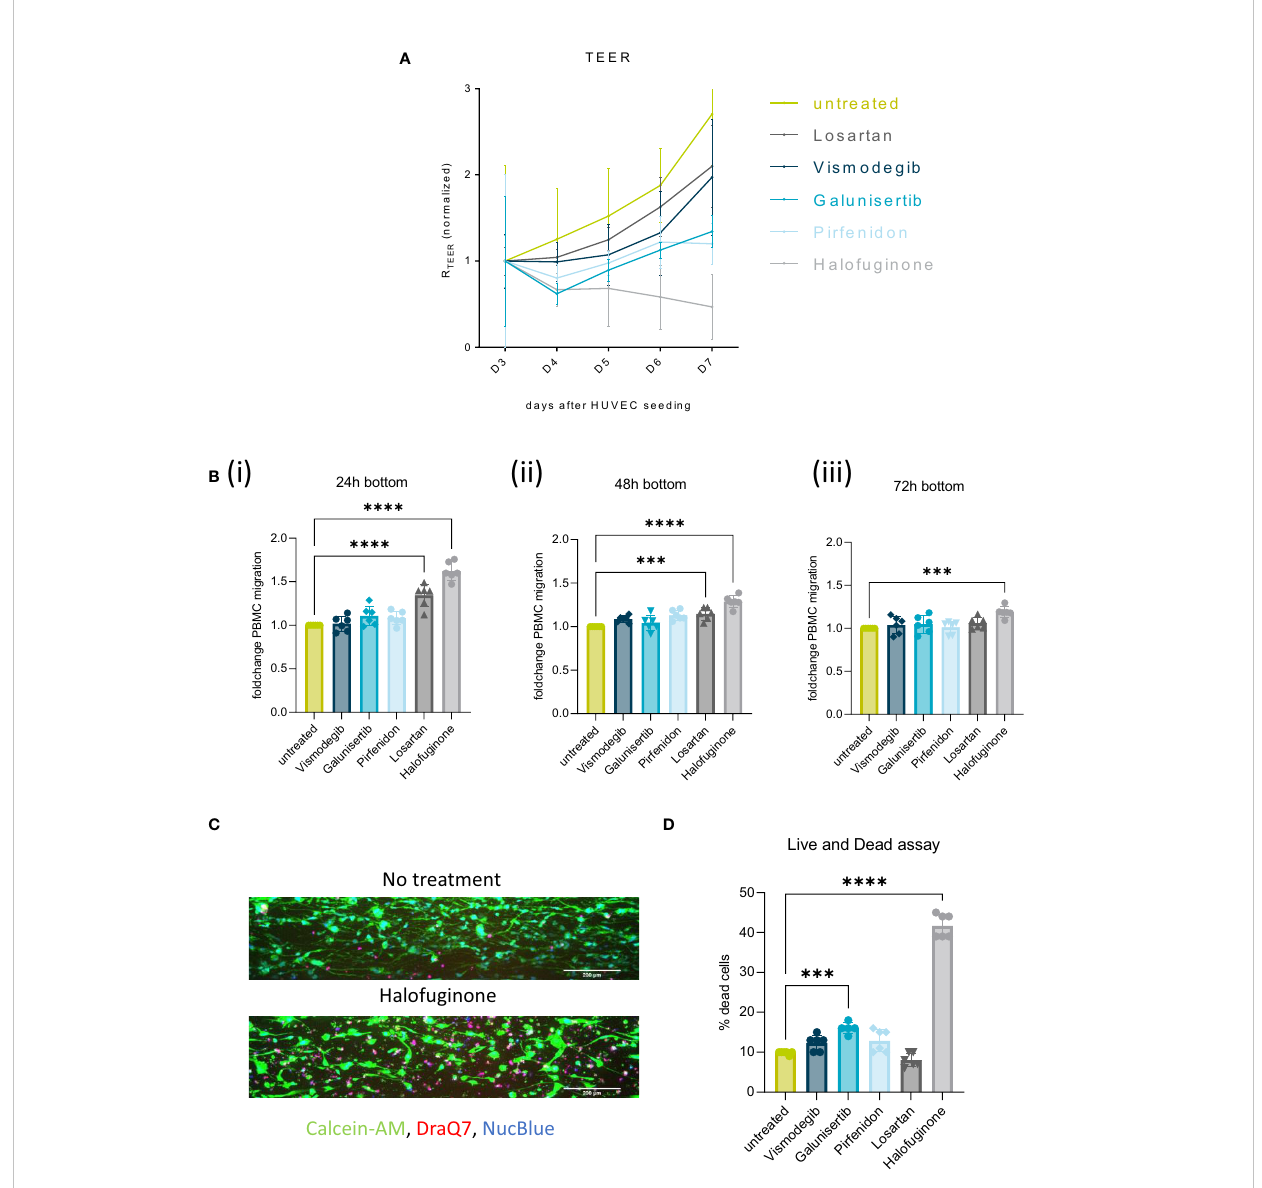
FIGURE 6 Stromal targeting in PDAC: (A) Barrier assessment of the culture setups when treated with 2 µM of either Vismodegib, Galunisertib, Pirfenidon, Losartan or Halofuginone with TEER. (B) Migration quanti fi cation of PBMCs migrated to the PDAC (bottom lane) at 24h(i), 48h(ii) and 72h(iii), when the stroma was treated with 2 µM of either Vismodegib, Galunisertib, Pirfenidon, Losartan or Halofuginone. The data, depicted as fold change, was normalized to the untreated control. Shown are mean +- SD (N=3, n=3). (C) Live and Dead assay with DraQ7 (red), Calcein-AM (green) and NucBLue (blue) showing the in fl uence of the compounds on cell death when treated with Halofuginone in the PSC lane. The cells were stained with Calcein- AM, DraQ7 and NucBlue (N=3, n=3), imaged on the ImageXpress Micro Confocal (Molecular Devices). 10x acquisition, Scale bar=200 µm (D) Live and Dead assay quanti fi cation showing the percentage of dead cells compared to the total number of cells. ***p< 0,001; ****p<